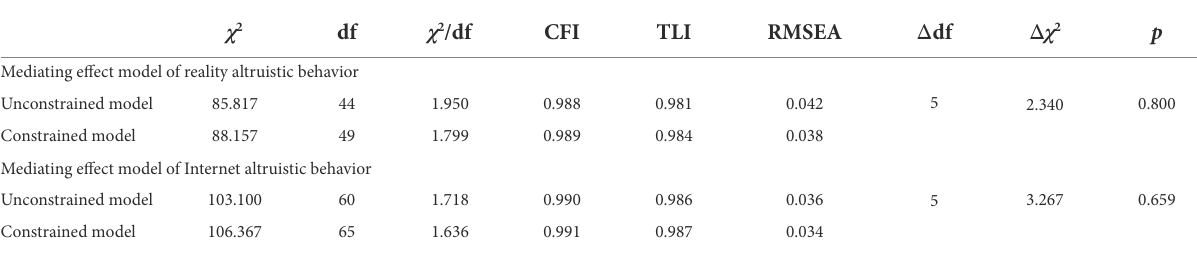
TABLE 3 Goodness-of-fit indices for the multiple group comparison